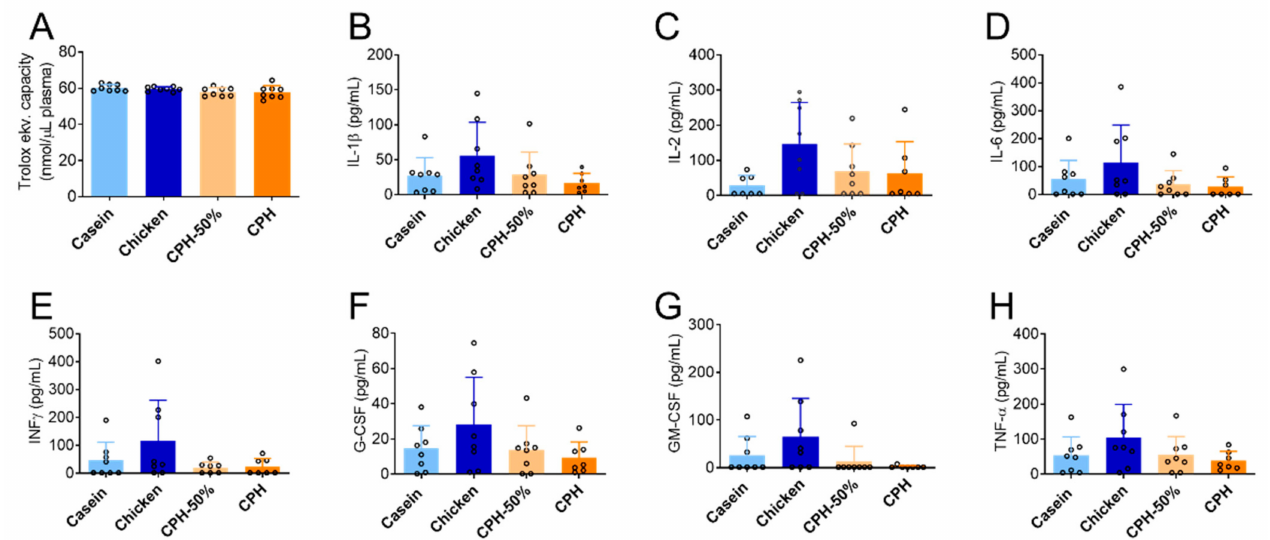
Figure 4. Dose effect of chicken protein hydrolysate (CPH) on plasma antioxidant and inflammatory parameters. ( A ) Plasma antioxidant capacity (AOC) and ( B – H ) cytokine and chemokine levels in Wistar rats fed high-fat diets with casein, chicken protein (meat) or different doses of CPH for 12 weeks. Means values with standard deviation are given, and individual values are indicated by circles ( n = 6–8). Significant difference was determined by one-way ANOVA with Tukey’s multiple comparisons test between all diet groups (no significance at p <